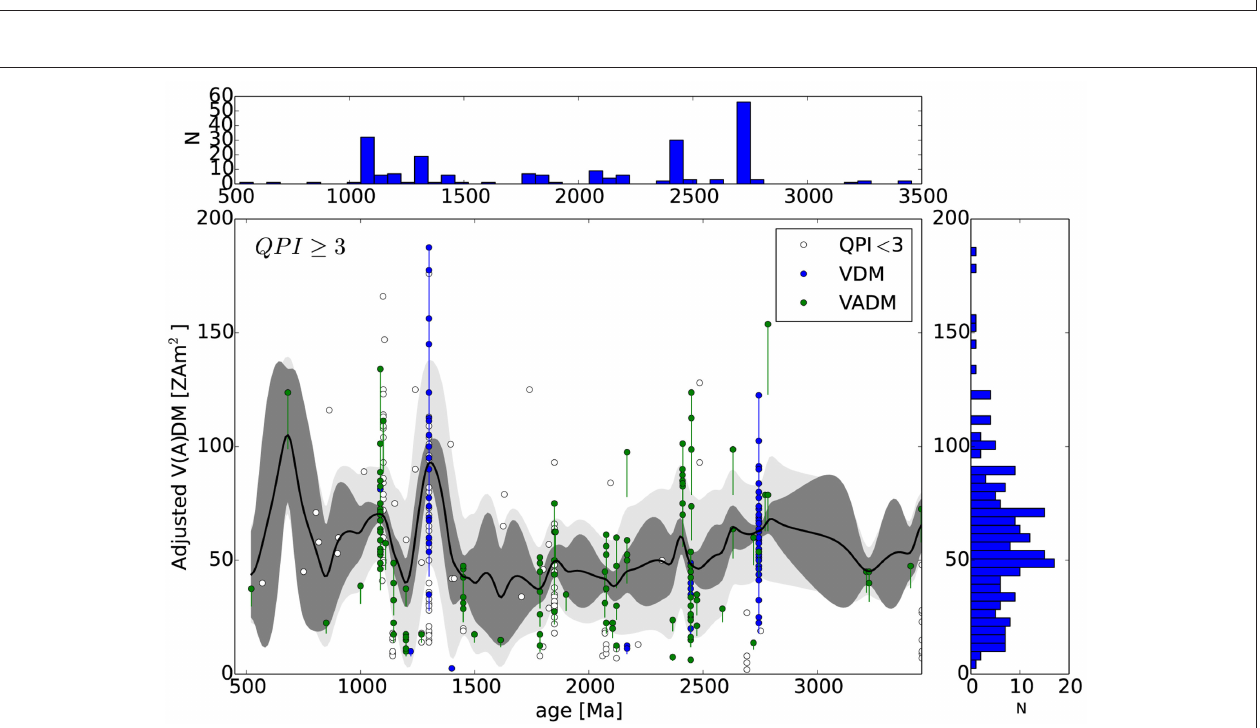
FIGURE 13 | Adjusted paleointensity (VDM and VADM) from the PINT database with inverse-distance squared smoothing with τ IDS = 30 Myr (solid line) applied to adjusted data with QPI ≥ 3 (filled circles). Open circles have QPI < 3. VDM’s are divided by 0.8, an estimate of the bias found in Figure 10 . VADM’s are divided by the same factor because they are also derived from magnetic paleoinclinations. Vertical lines connect adjusted to original values. (Right) histogram of VDM and VADM. (Top) histogram of ages.